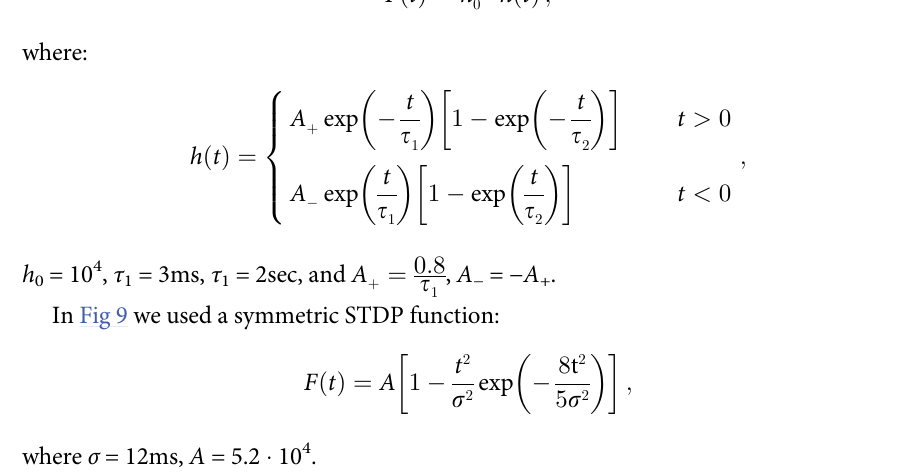
where σ = 12ms, A = 5.2 (cid:5) 10 4 .